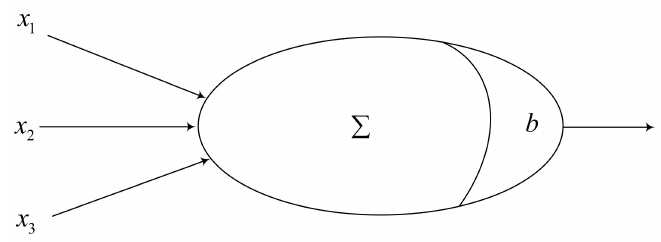
Figure 1. The structure of the MP neuron